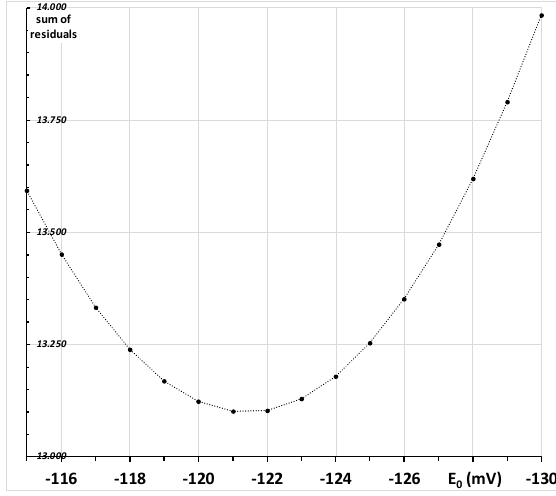
Figure A3. Least-squares residuals plot of calculated and measured concentrations of HbSSG, calculated by changing the value of E 0 between − 130 and − 115 mV in 1-mV steps.